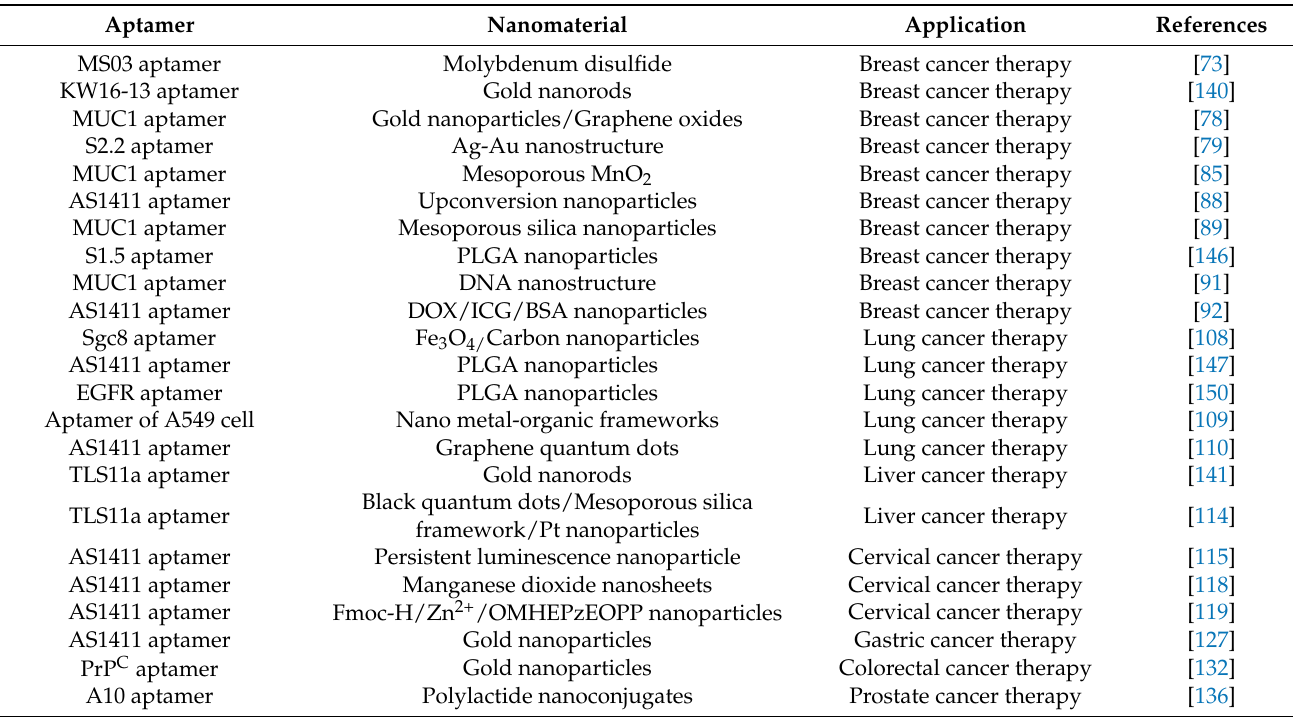
Table 1. Summary of Aptamer-Bound Nanomaterials in Cancer